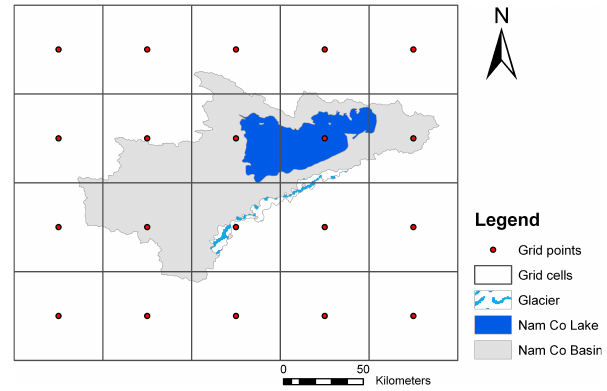
Fig. 2. Simplified spatial distribution of modelling units and climate grid